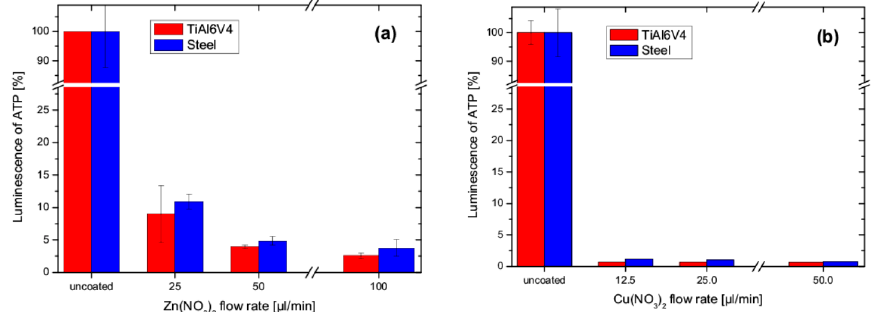
Figure 8. Influence of the flow rate used for ( a ) Zn-SiO x films grown with a secondary precursor concentration of 5 wt.% Zn(NO 3 ) 2 and ( b ) Cu-SiO x films grown with a secondary precursor concentration of 2.5 wt.% Cu(NO 3 ) 2 on detectable luminescence of ATP compared to uncoated austenitic stainless steel and TiAl6V4 reference samples.